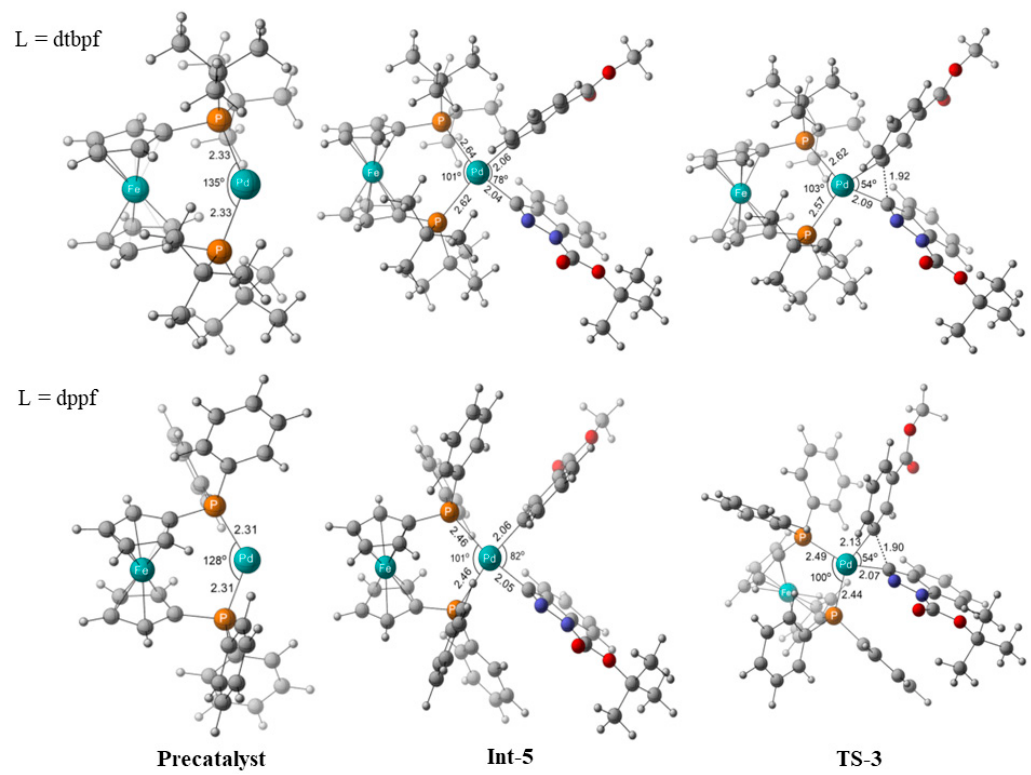
Figure 6. Selected optimized geometries of Precatalyst , Int-5 , and TS-3 . Bond distances in Å and angles in degrees.